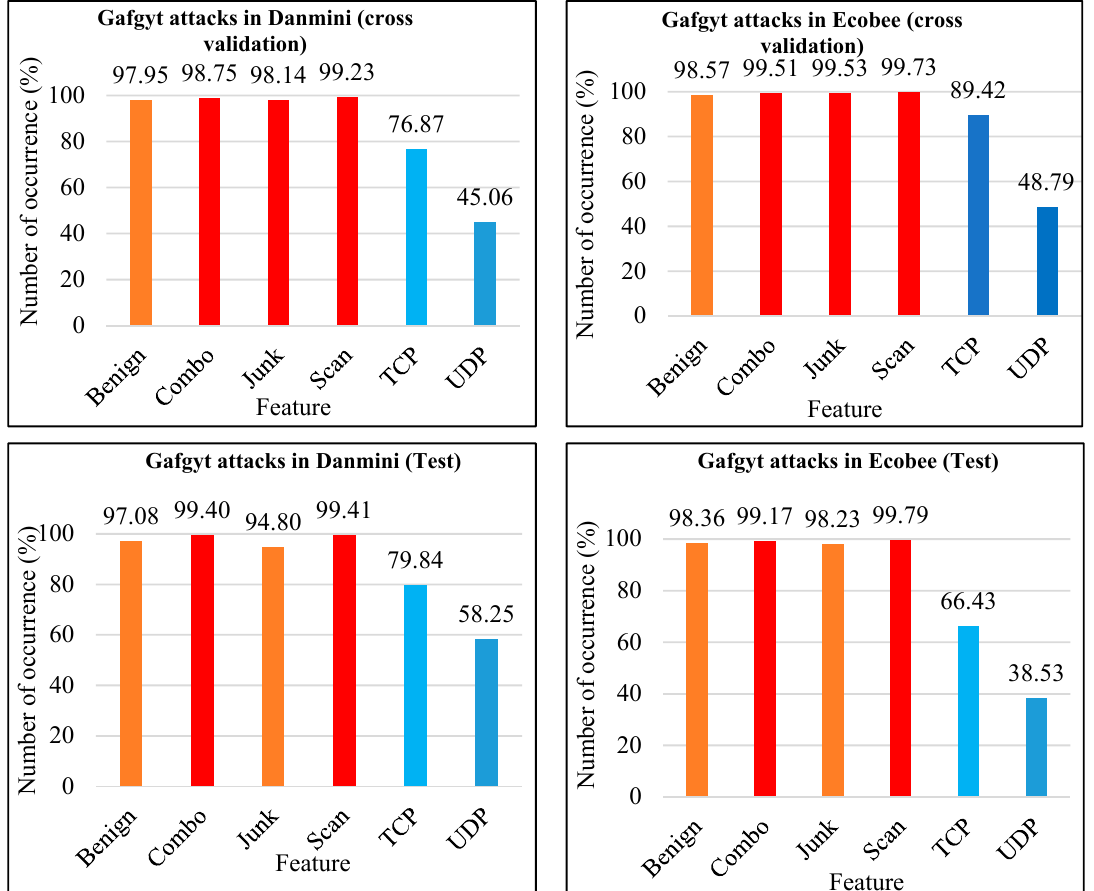
Figure 5. An overview of the features in the Botnet dataset (the number of occurrences of each feature with two di ff erent analysis).